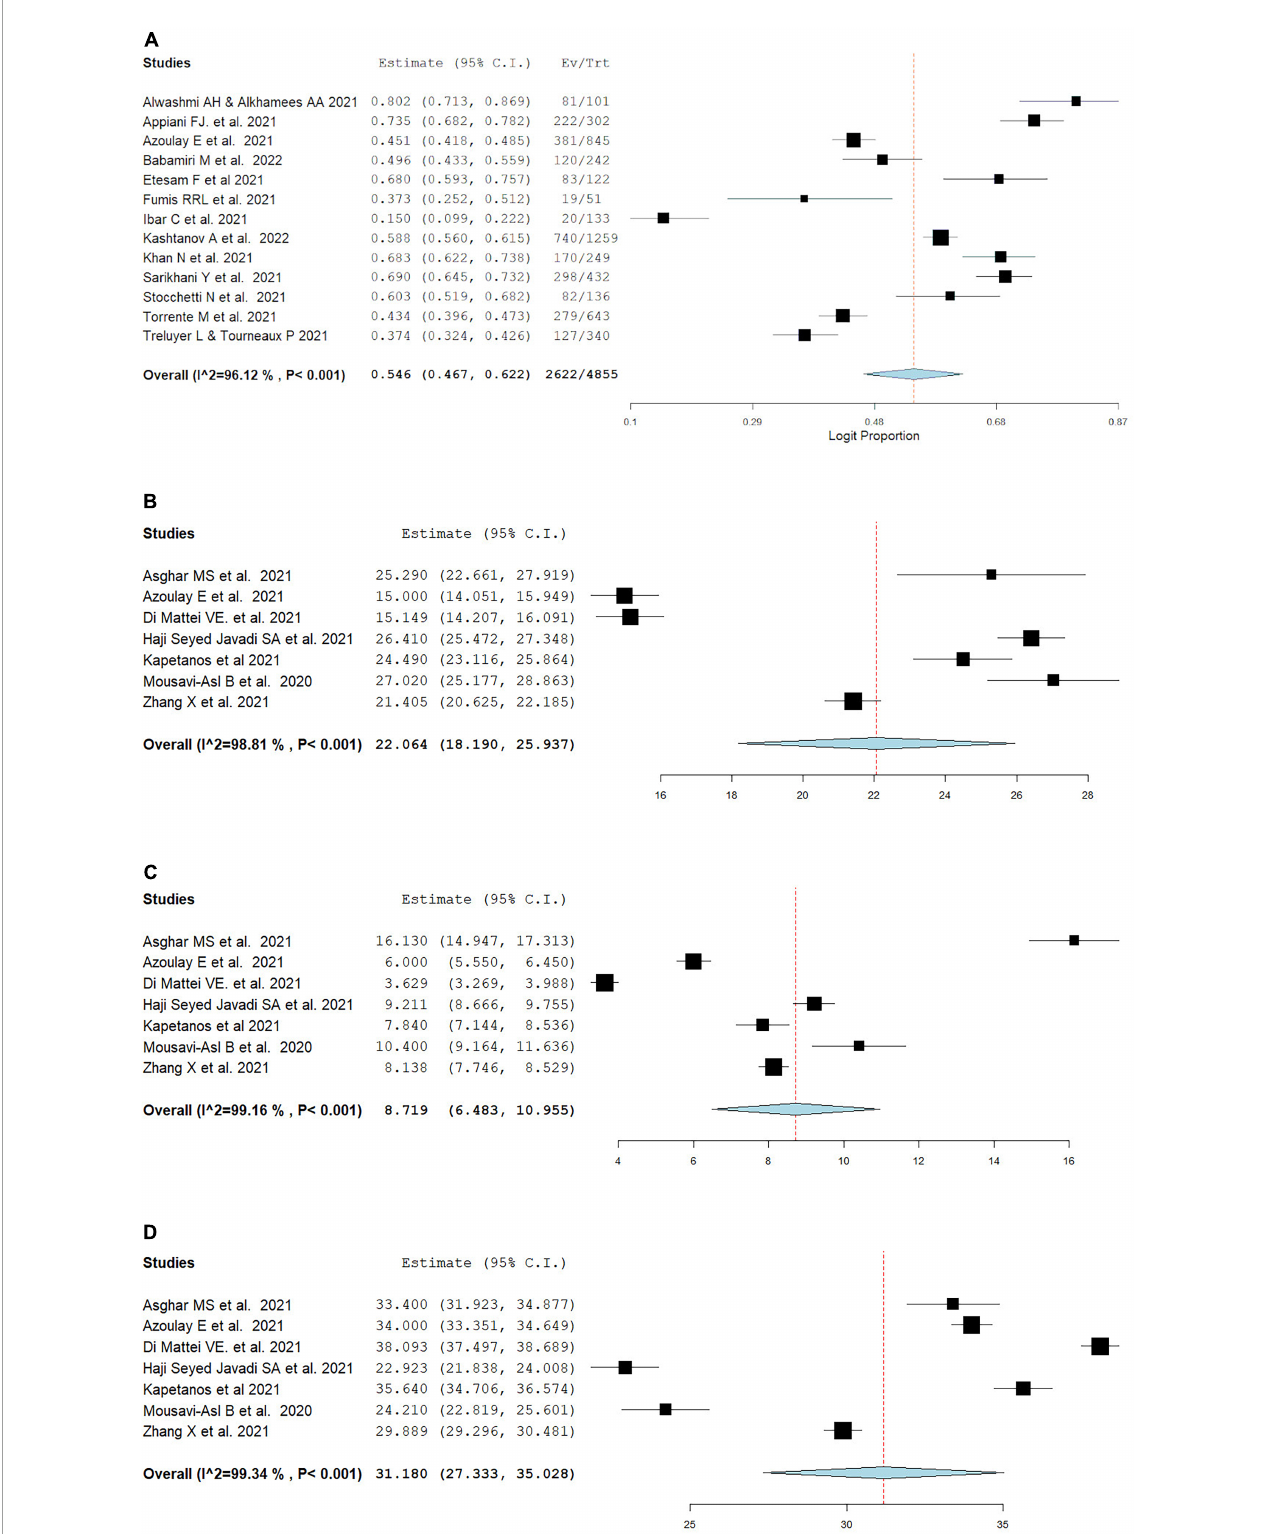
FIGURE1 Pooled estimate of overall burnout in healthcare workers according to the Maslach burnout inventory by (A) overall prevalence, (B) emotional exhaustion, (C) depersonalization, (D) personal